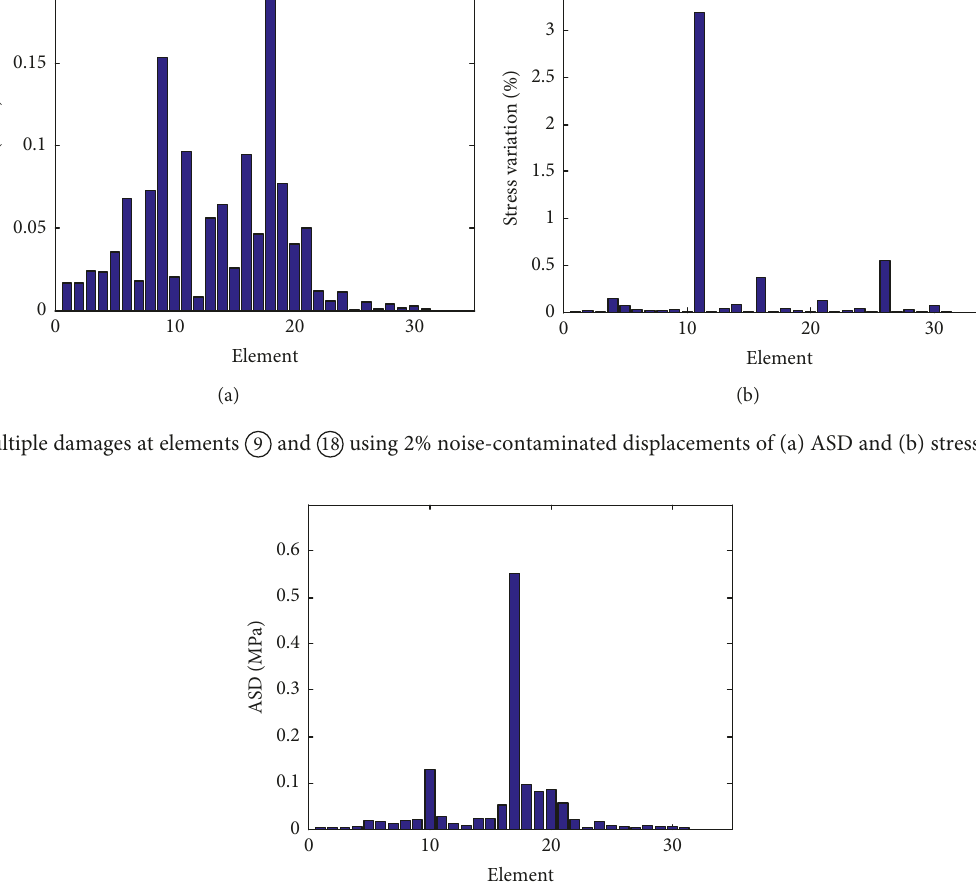
Figure 14: ASD of the truss with multiple damages at elements 10 and 17 using 3% noise-contaminated displacements and local-based approach.